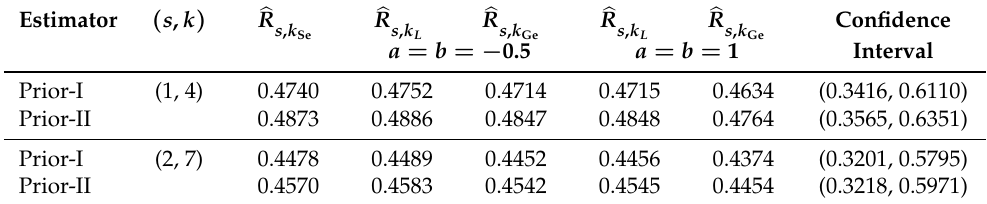
Table 15. The result of Bayesian estimation for waiting time